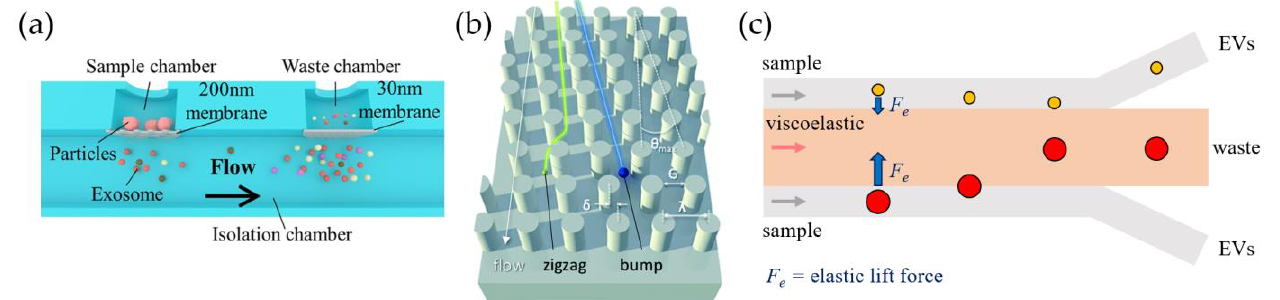
Figure 3. EV isolation methods based on passive approaches. ( a ) Double-membrane system to enrich sEVs (exosomes) of sizes between 30 and 200 nm [38]; ( b ) silicon array of pillars placed inside the chip to induce different zigzag pathways based on particle dimension [46]; ( c ) microfluidic device allowing collection of extracellular vesicles from initial sample mediated by elastic force from viscoelastic fluid.